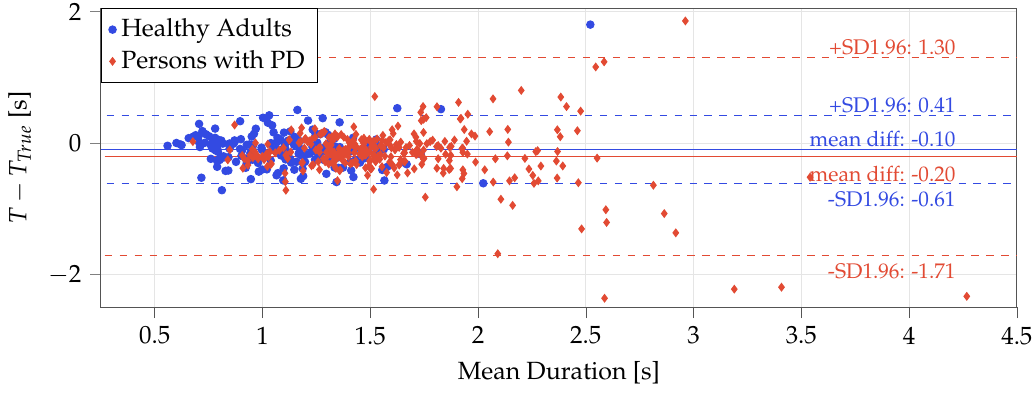
Figure 2. Bland–Altman plot showing difference in the duration of the STS transfers detected using the displacement method ( T ) and ground truth ( T true ) for the in-lab data from the healthy subjects (red dots) and the persons with PD (blue diamonds). Two outliers in the PD data fall beyond the range of the graph limits and are therefore not visible.